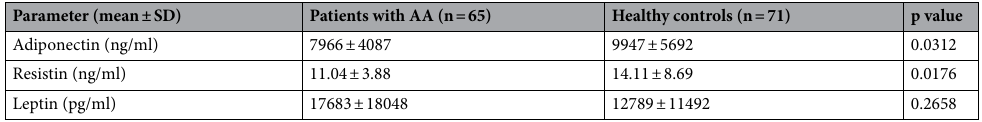
Table 2. Serum concentrations of adiponectin, resistin and leptin in patients with alopecia areata and healthy controls. SD standard deviation, AA alopecia areata.